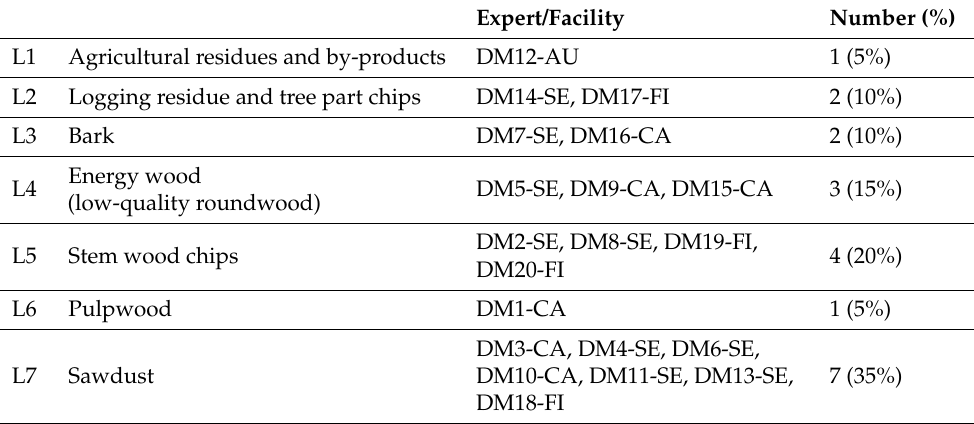
Figure 5. Weighting and ranking of the preferred biomass feedstock attributes, aggregated by country and total values ( n = 20; definitions of attribute codes are given in Table 1). Table 5. Type (level) of biomass assortment (attribute A1) ranked first by the respondents (codes and descriptions of the bioenergy facilities are described in Table A1. AU: Australia, CA: Canada, FIN: Finland, SE: Sweden).